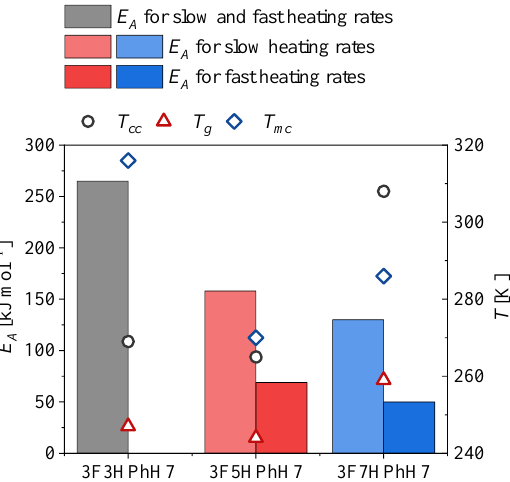
Figure 10. The activation energies (bar plot) and the temperatures of the non-isothermal cold crystallization (scatter plot) of 3F m HPhH7 homologues obtained for slow and fast heating rates.